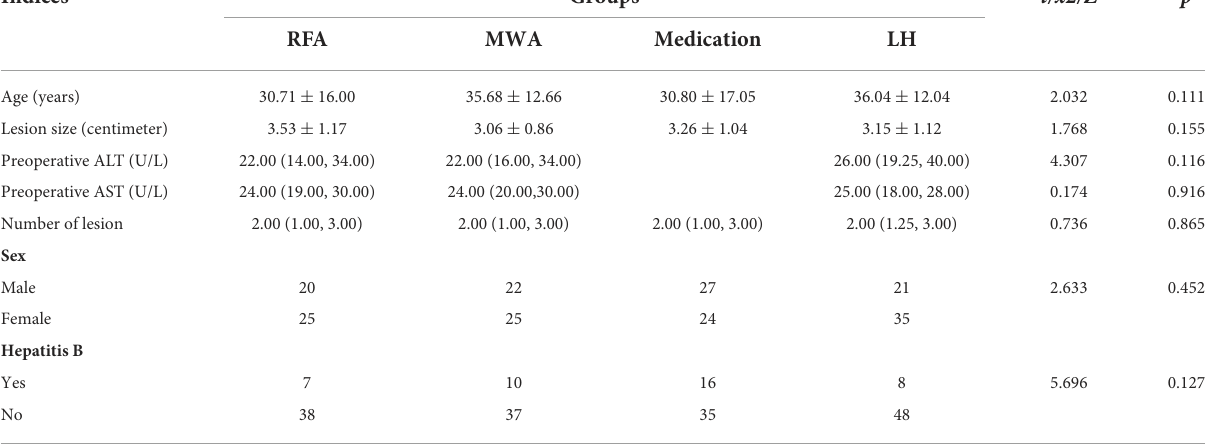
TABLE 1 Comparison of baseline data of patients with different therapies. Indices Groups t/x2/Z